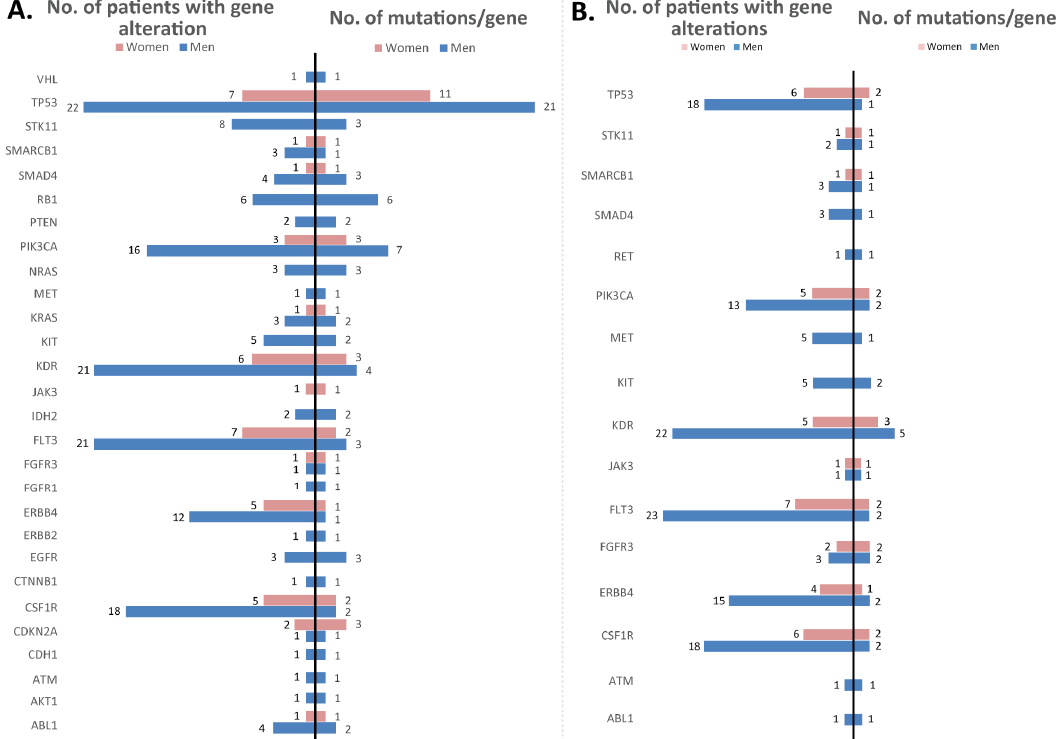
Figure 6. Bar graph representing the number of different mutations identified in each gene (left) and the number of patients in which at least one variant was detected for each gene (eight) in women (pink) and men (blue) in tumor tissue samples ( A ) and whole blood samples ( B ).